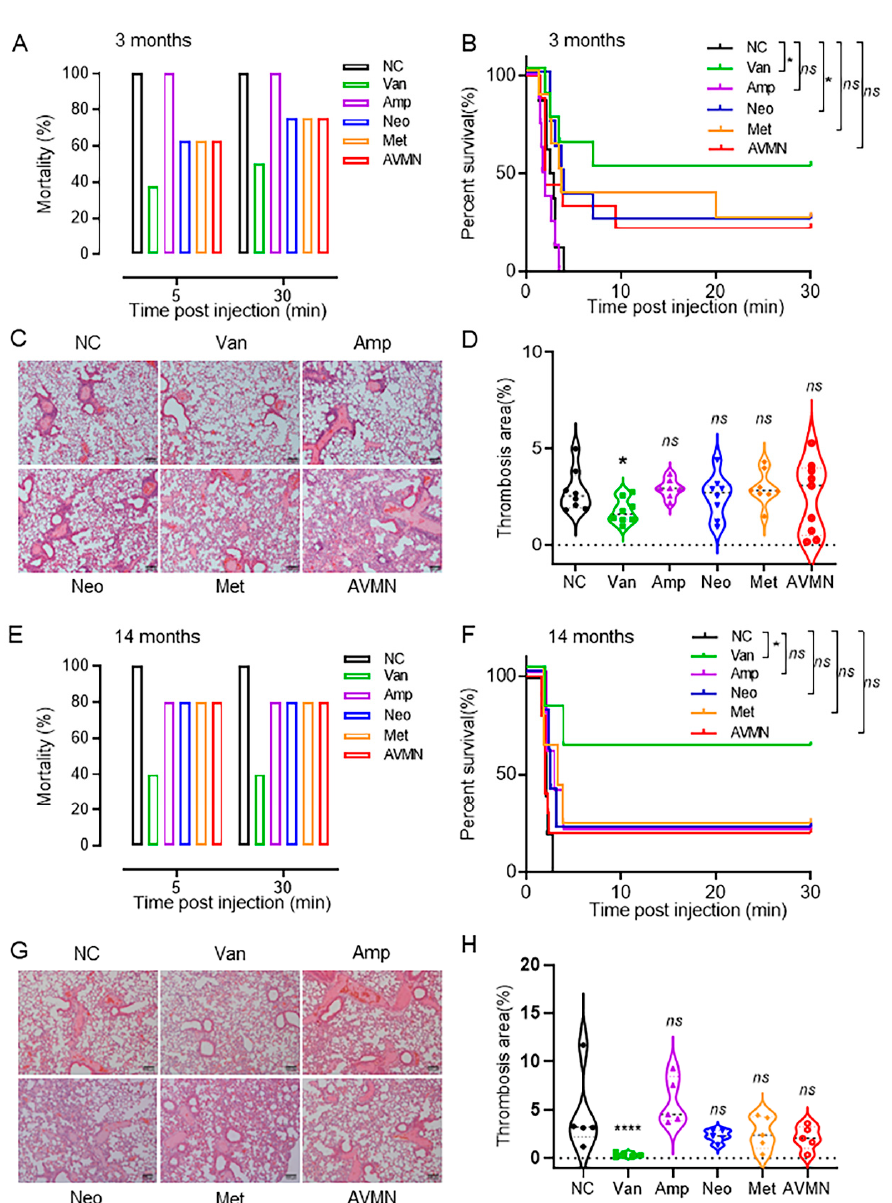
Figure 1. Vancomycin treatment reduces mortality in mice with pulmonary embolism. Three-month-old male mice were randomly divided into six groups including control (NC), vancomycin (Van) (n = 8), ampicillin (Amp) (n = 8), metronidazole (Met) (n = 8), neomycin (Neo) (n = 8), and an antibiotic cocktail Group (AVMN) (n = 9). ( A ) Mortality of PE mice in each group during the 30-min observation period. ( B ) Kaplan–Meier survival percentage of the mice in each group. ( C ) Representative images of H&E staining of lung tissue sections obtained from each group of mice, scale bar: 100 µ m. ( D ) Quantitative analysis of thrombus area in lung tissue. ( E – H ) A model of pulmonary embolism was induced using 14-month-old male mice. NC, n = 5; Van, n = 5; Neo, n = 5; Amp, n = 5; Met, n = 5; AVMN, n = 10. Mortality ( E ) and Kaplan–Meier survival percentage ( F ) of PE mice in each group during the 30-min observation period. Representative images of mouse lung tissue sections of each group after H&E staining ( G ), scale bar: 100 µ m. Quantitative analysis of thrombus area in lung tissue ( H ). * p < 0.05, **** p <